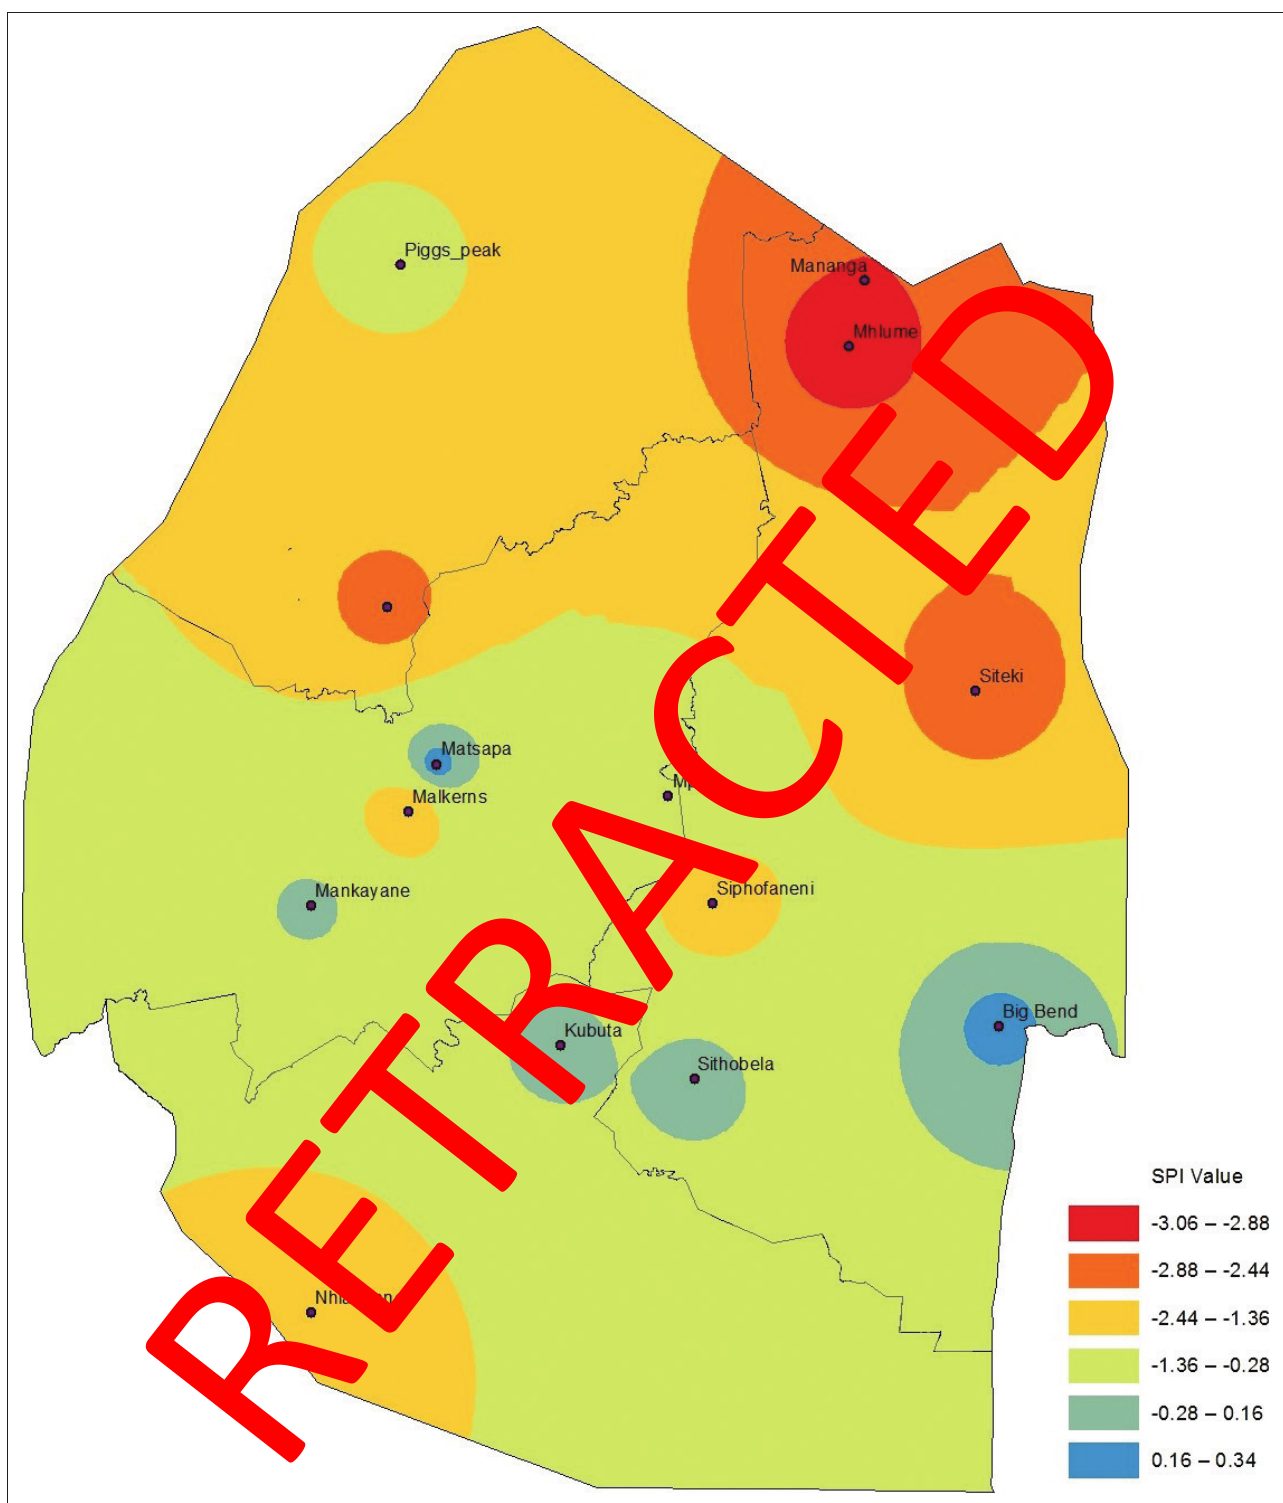
FIGURE 9: Standard Precipitation Index 3-month timescale during